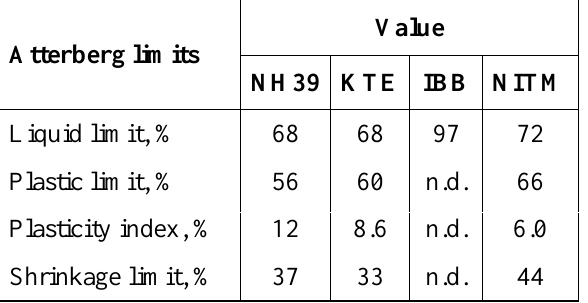
Table 4. Strength parameters of Northeast Indian peats. UCS: unconfined compressive strength; c : cohesion; φ : friction angle.